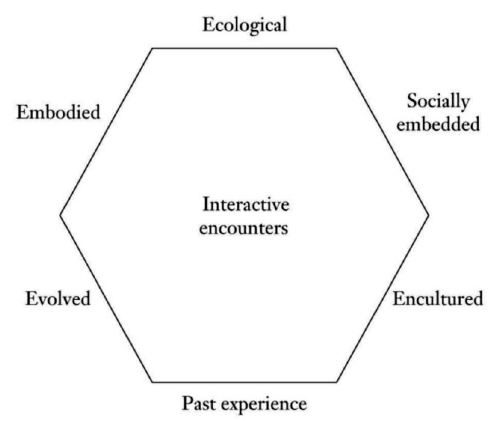
Figure 1. Constraints on experience and meaning within individual interactive encounters (Nelson 2007, p.